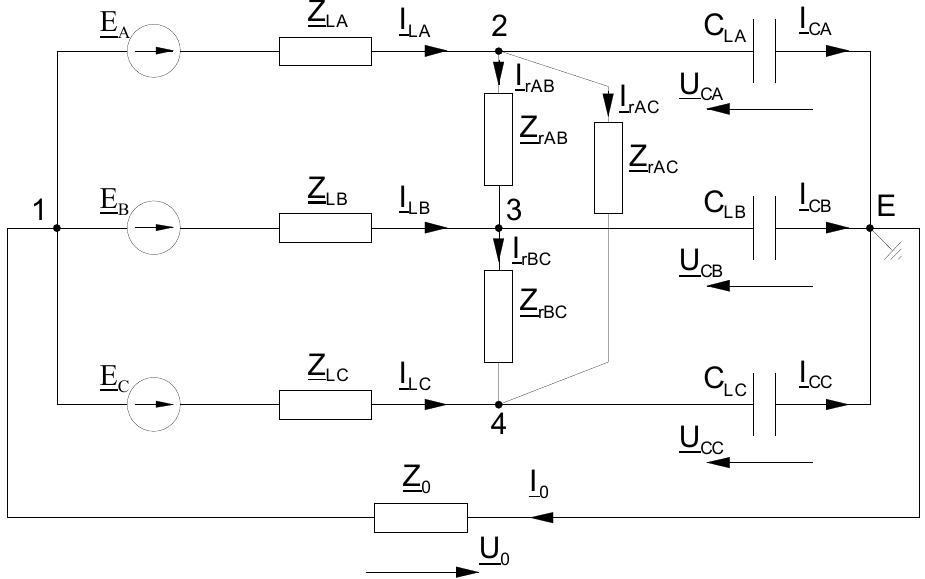
flow—Figure 5. The arrangement of voltage vectors corresponding to the loaded network is shown in Figure 6.